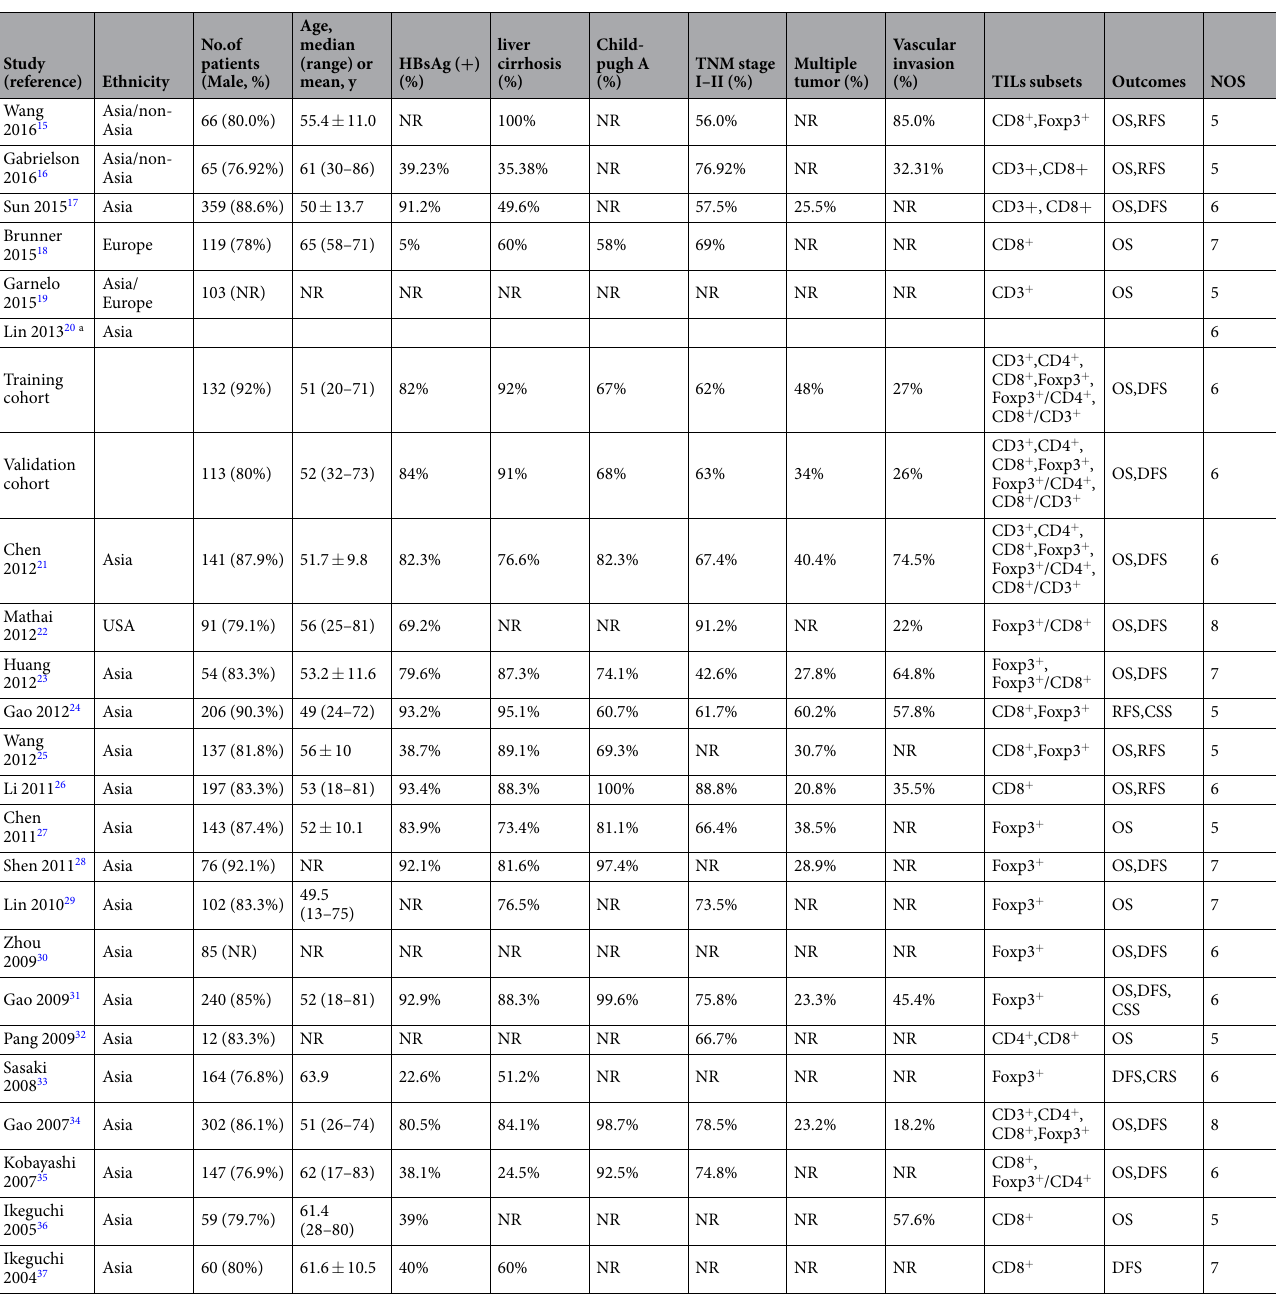
Table 1. Characteristics of the involved studies. NR: not reported. a This study was divided into two independent terms, training cohort and validation